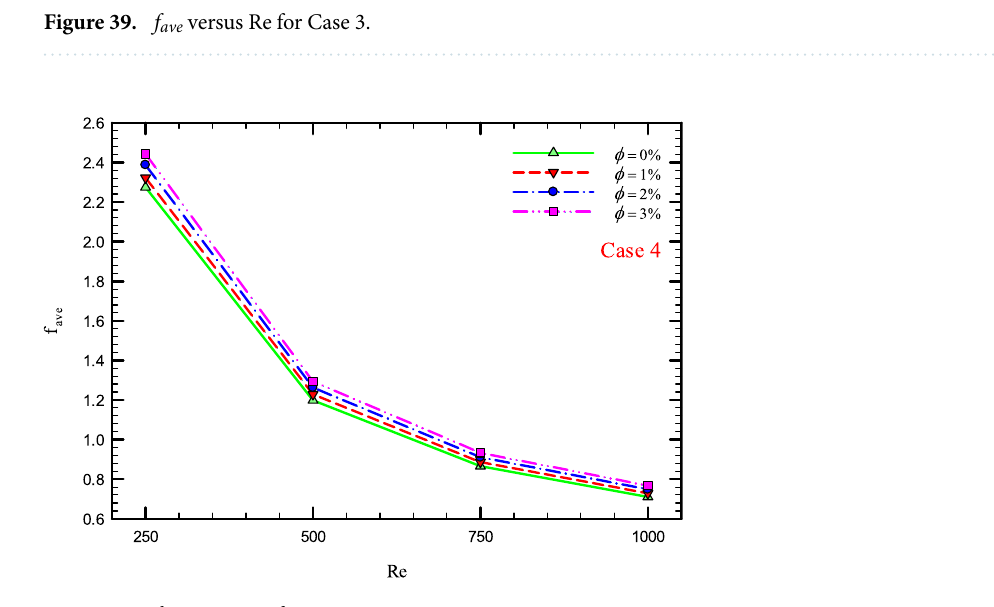
Figure 40. f ave versus Re for Case